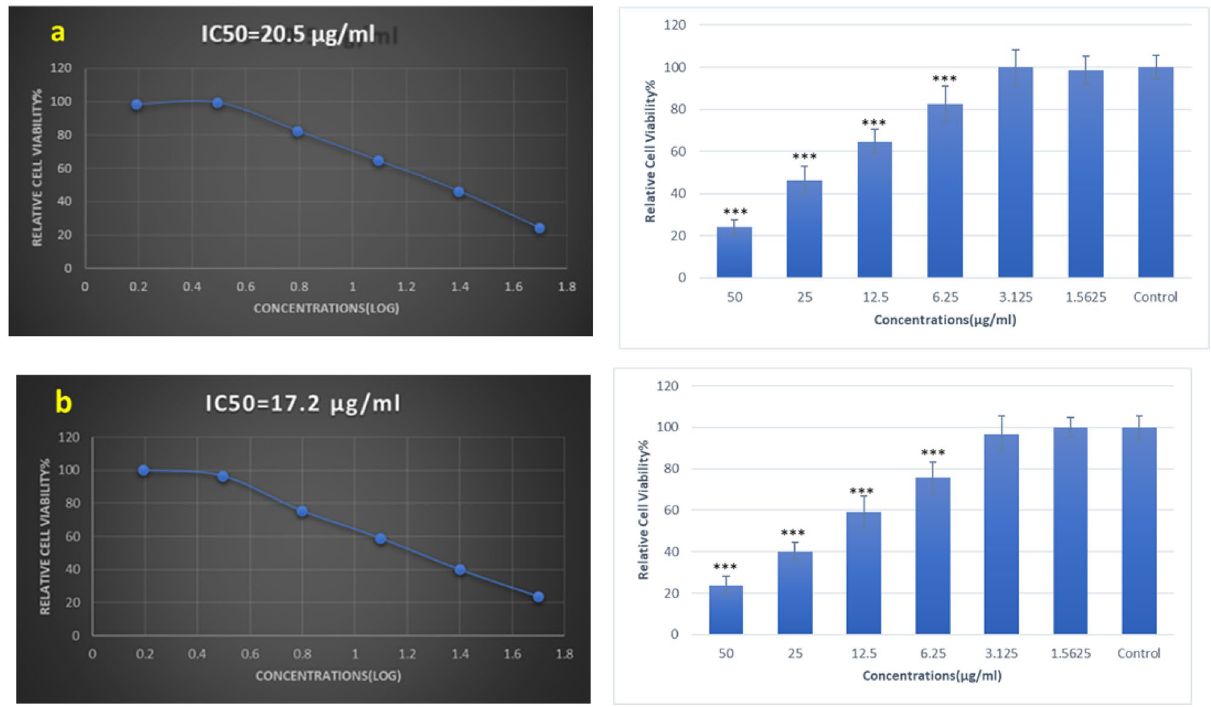
Figure 15. The viability of HEK-293 cells, 24 h after treatment with ZnTPP/Cu-NPs (3) ( a ) and ZnTPP/ Cu-NPs-PAA (3) ( b